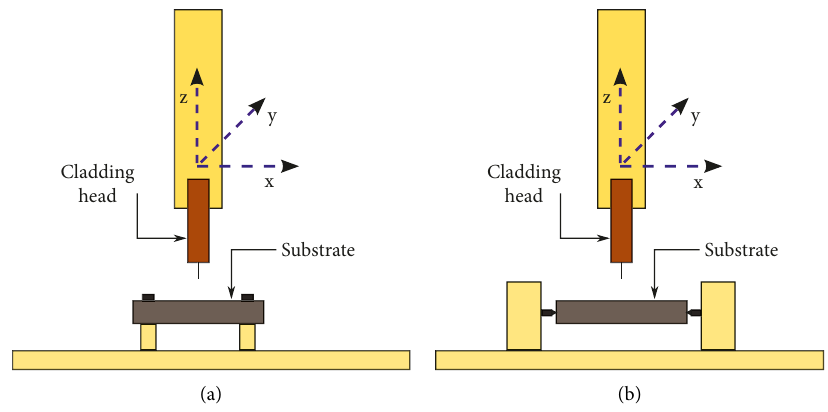
Figure 4: Clamping arrangement for embedded substrate method. (a) Jig-based setup. (b) Index